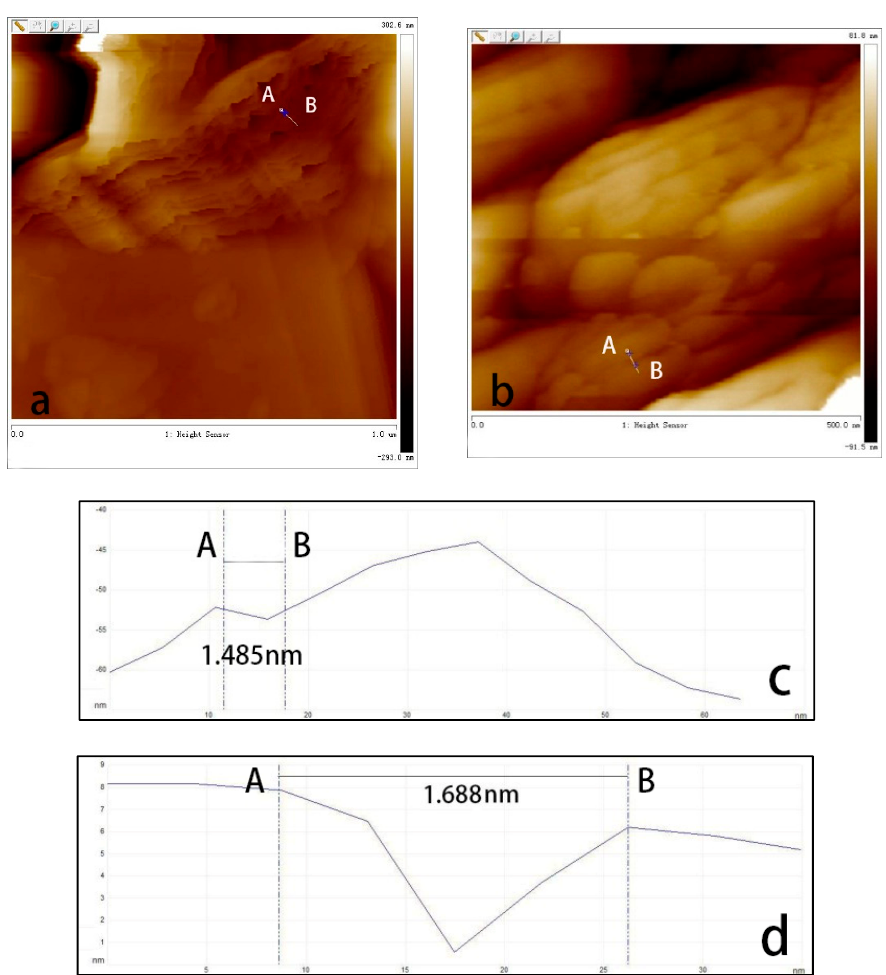
Figure 16. Single piece thickness test of GNPs ( a , c ) and GOs-SH ( b , d ) by